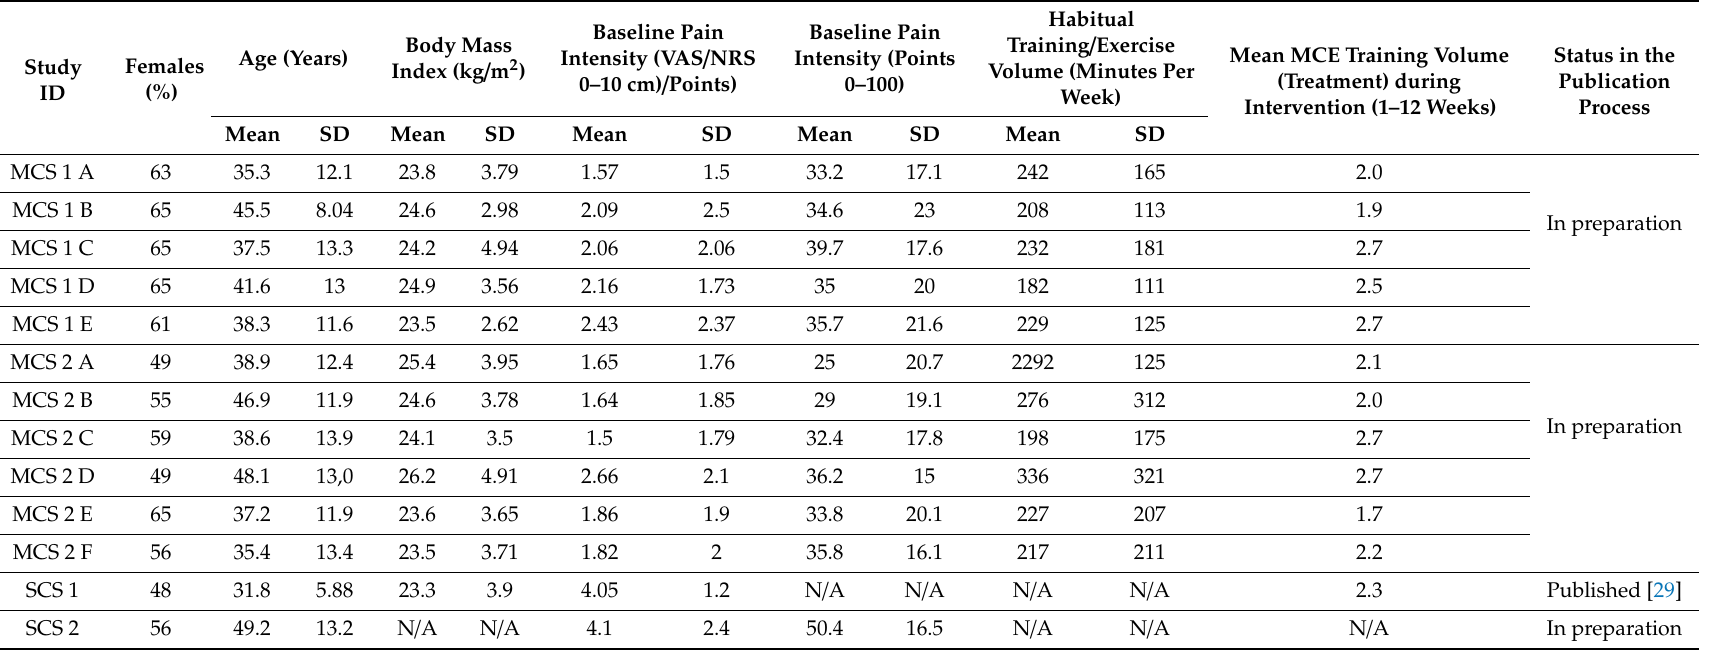
Table 1. Participants’ characteristics at baseline (all participants) and training (intervention group only)